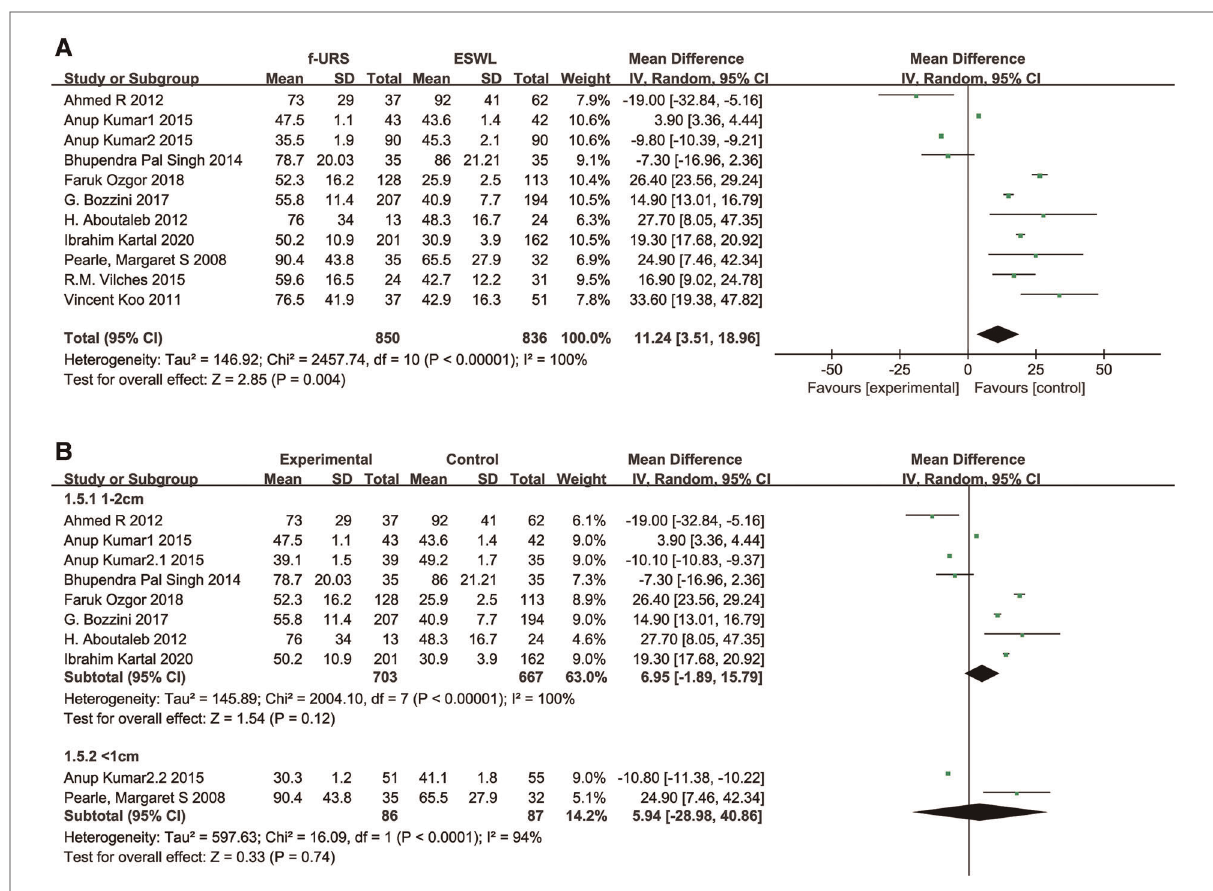
FIGURE 8 Forest plot and meta-analysis of operation time for ( A ) all studies and ( B ) subgroups of stone length 1 – 2 cm and <1 cm for f-URS and SWL.